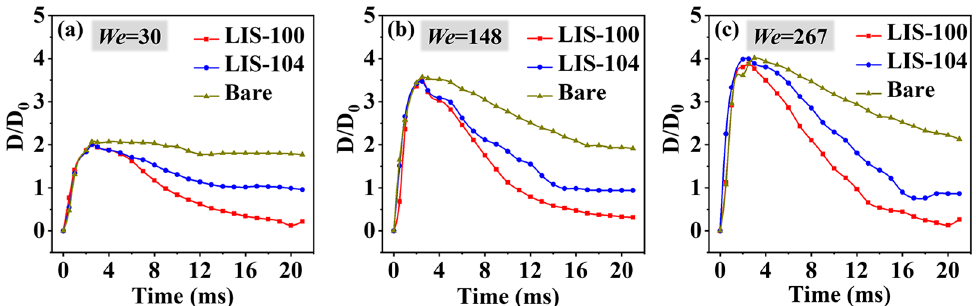
Figure 4. The time evolution of the spreading factor (the diameter of the impacting droplet normalized by the initial droplet diameter) on the sample surfaces at ( a ) We = 30, ( b ) We = 148 and ( c ) We = 267.